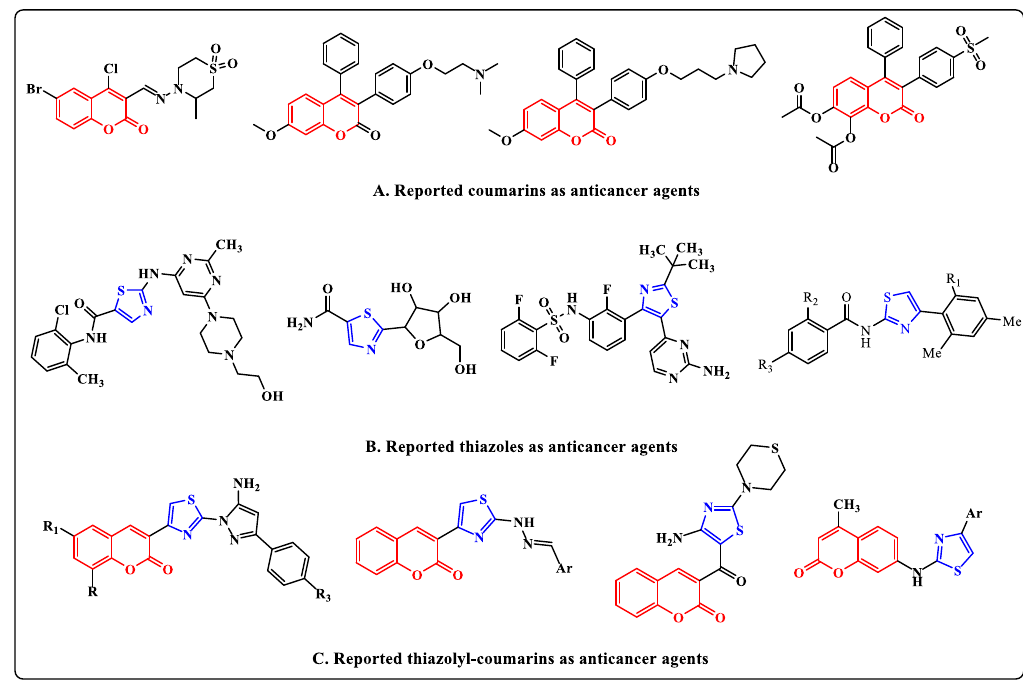
Figure 1. Examples of some reported coumarins, thiazoles and thiazolylcoumarins as anticancer agents.